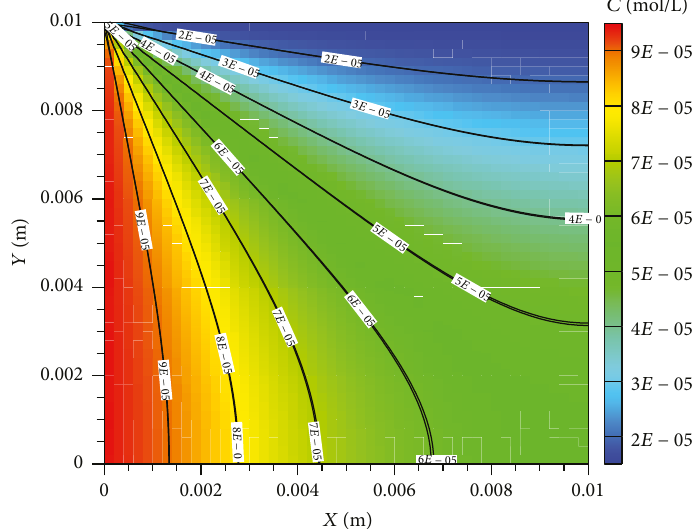
Figure 31: Steady-state concentrations, obtained by analytical (contour and solid lines) and LB (dashed lines) methods, for a single species di ff using through the left boundary of a square domain and reacting at the top boundary according to a fi rst-order reaction while other boundaries are zero concentration